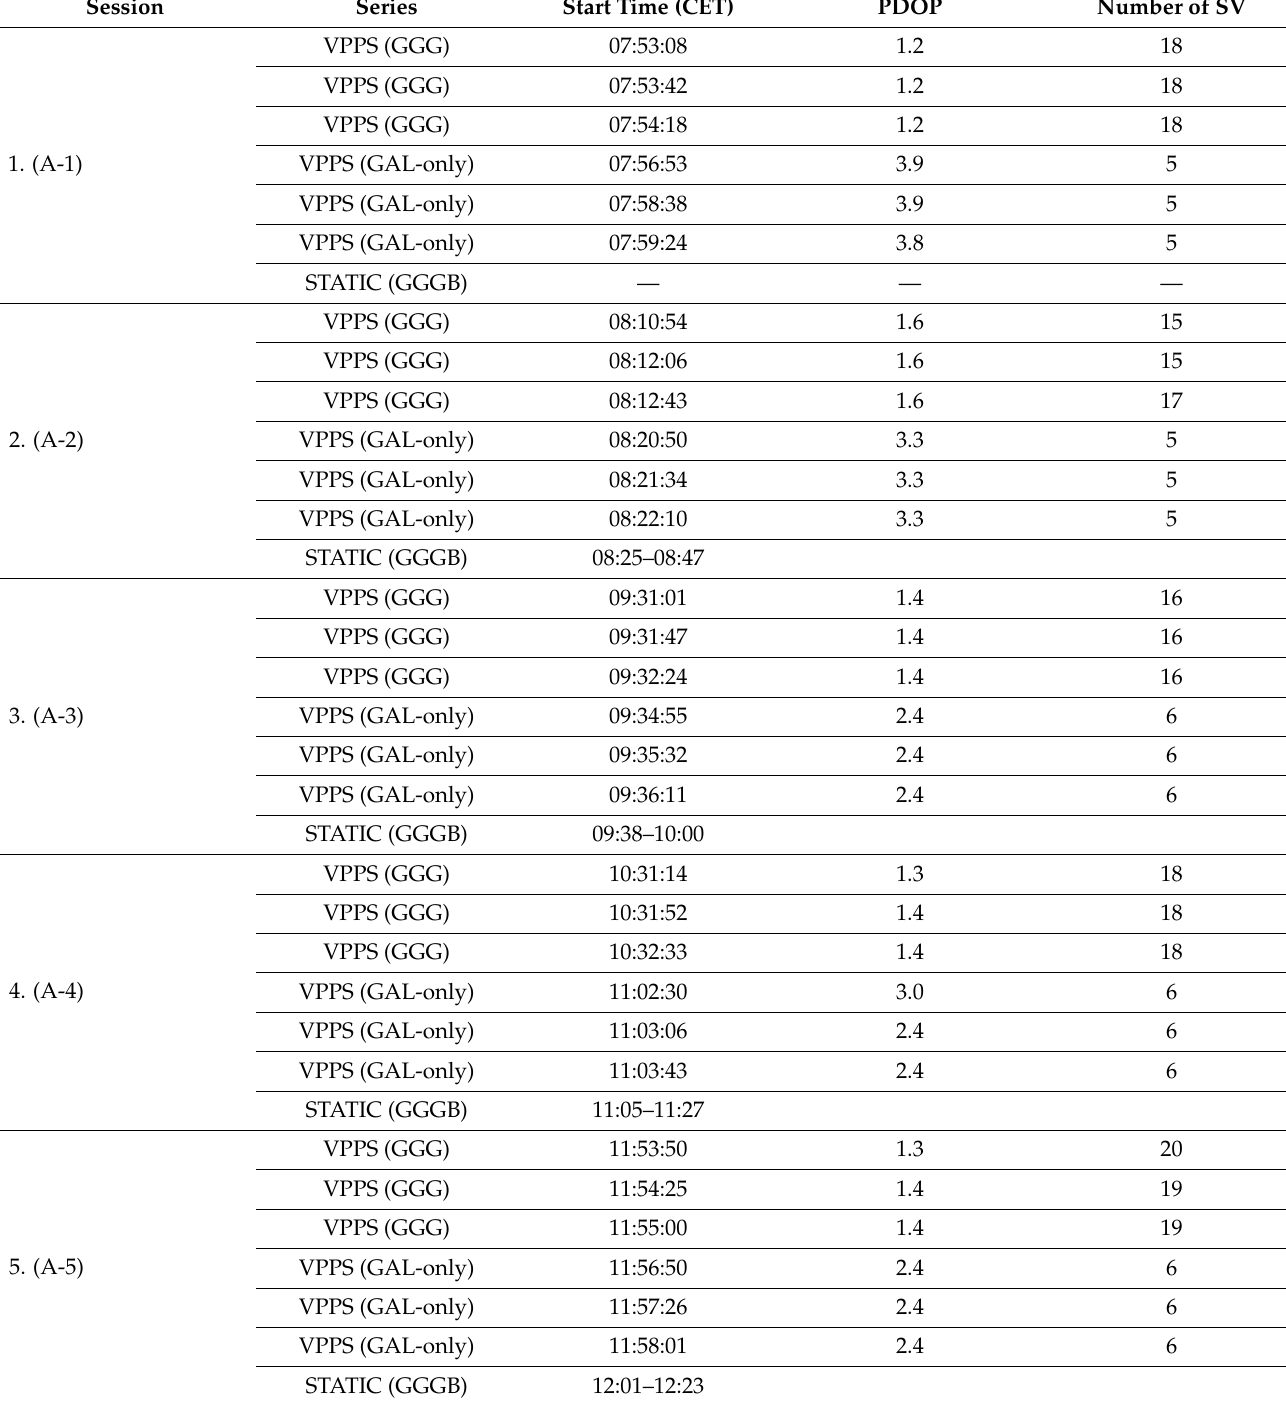
Table 2. Observation sessions and series of VPPS and GPPS (STATIC) as they were carried